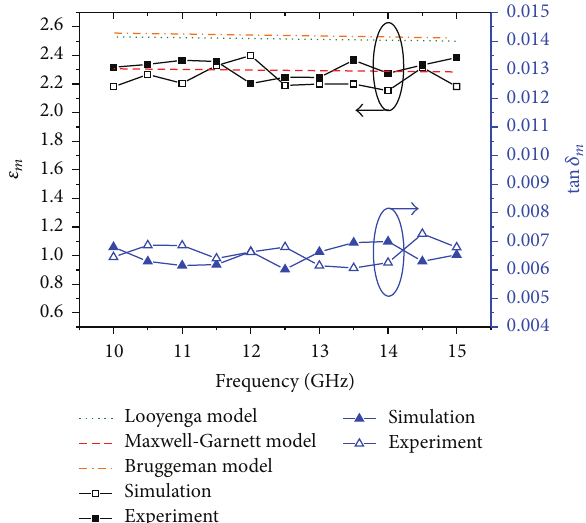
Figure 9: Theoretical, experimental, and simulated results of 𝜀 𝑚 and tan 𝛿 𝑚 in the frequency band with 𝐻 = 3 mm.